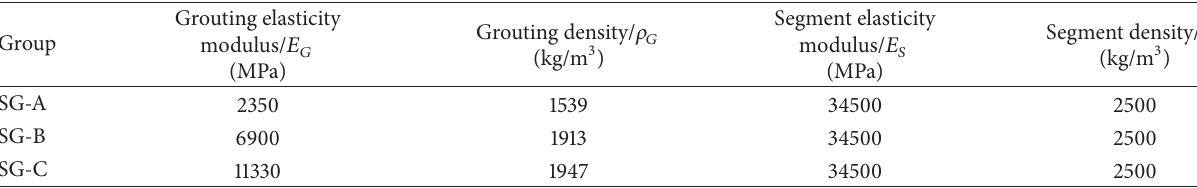
Table 1: Material parameters of SG samples.